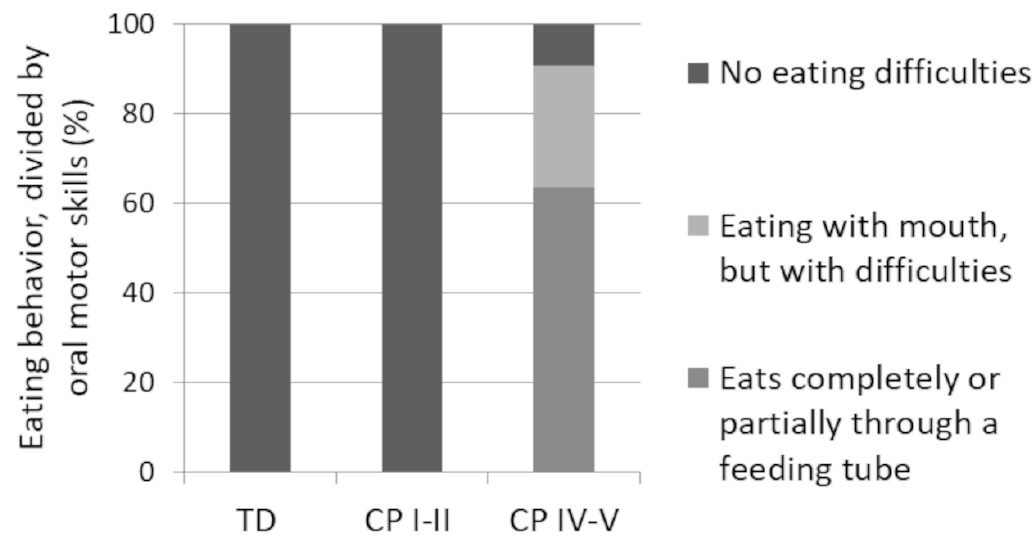
Figure 2. Eating behavior divided by oral motor skills in percentage of TD children (n = 16) and children with CP at GMFCS level I–II (n = 13) and IV–V (n =